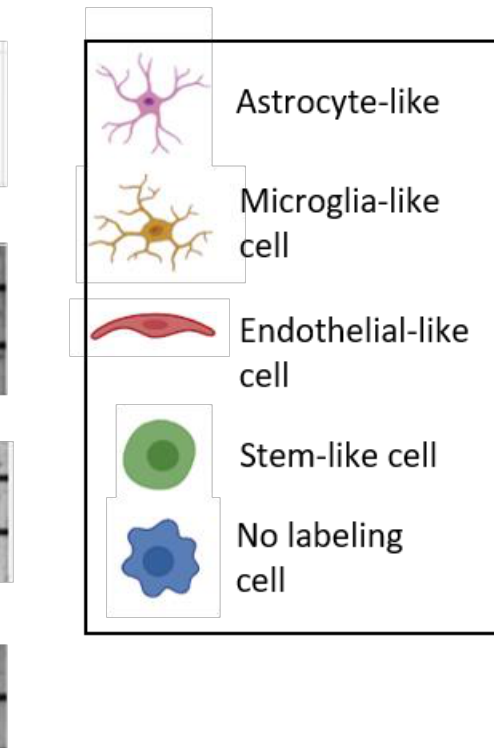
Figure 3. Pie charts of the percentages of the main cell type populations found in GB01, GB02, and GB03.